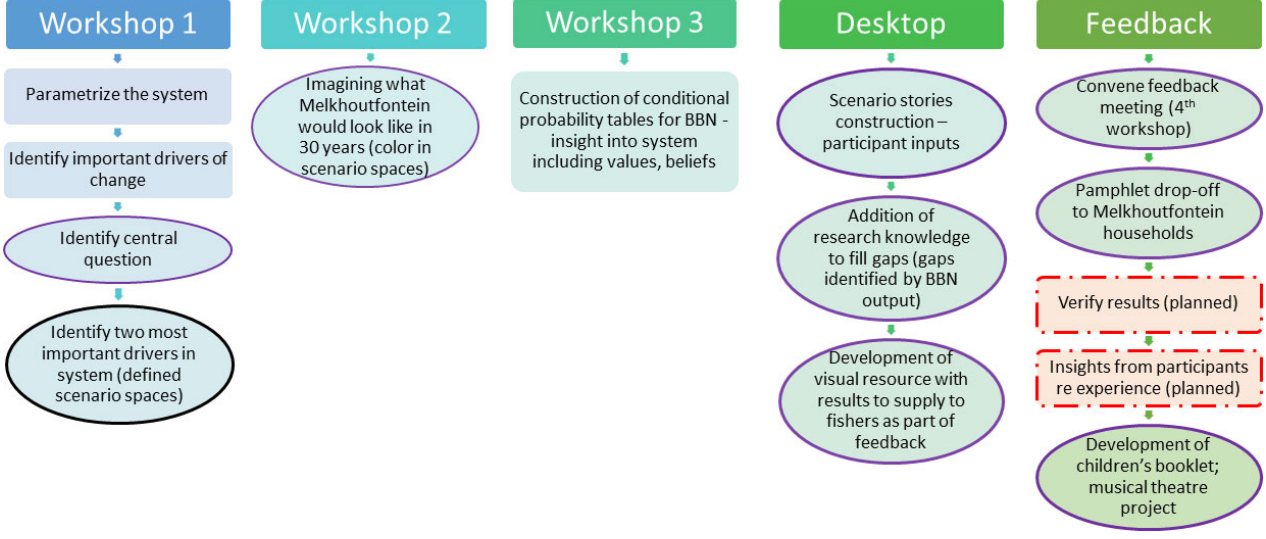
Fig. 3 . The scenario development process followed in the Melkhoutfontein prototyping exercise. The causal map and Bayesian belief network development process in Workshops One and Three, delivered their own, separate outputs (detailed in Gammage and Jarre 2020) while informing the final scenario stories. Feedback was initially planned in a fourth workshop that did not take place. Steps pertaining to this component of the research are indicated by oval shapes. BBN = Bayesian belief